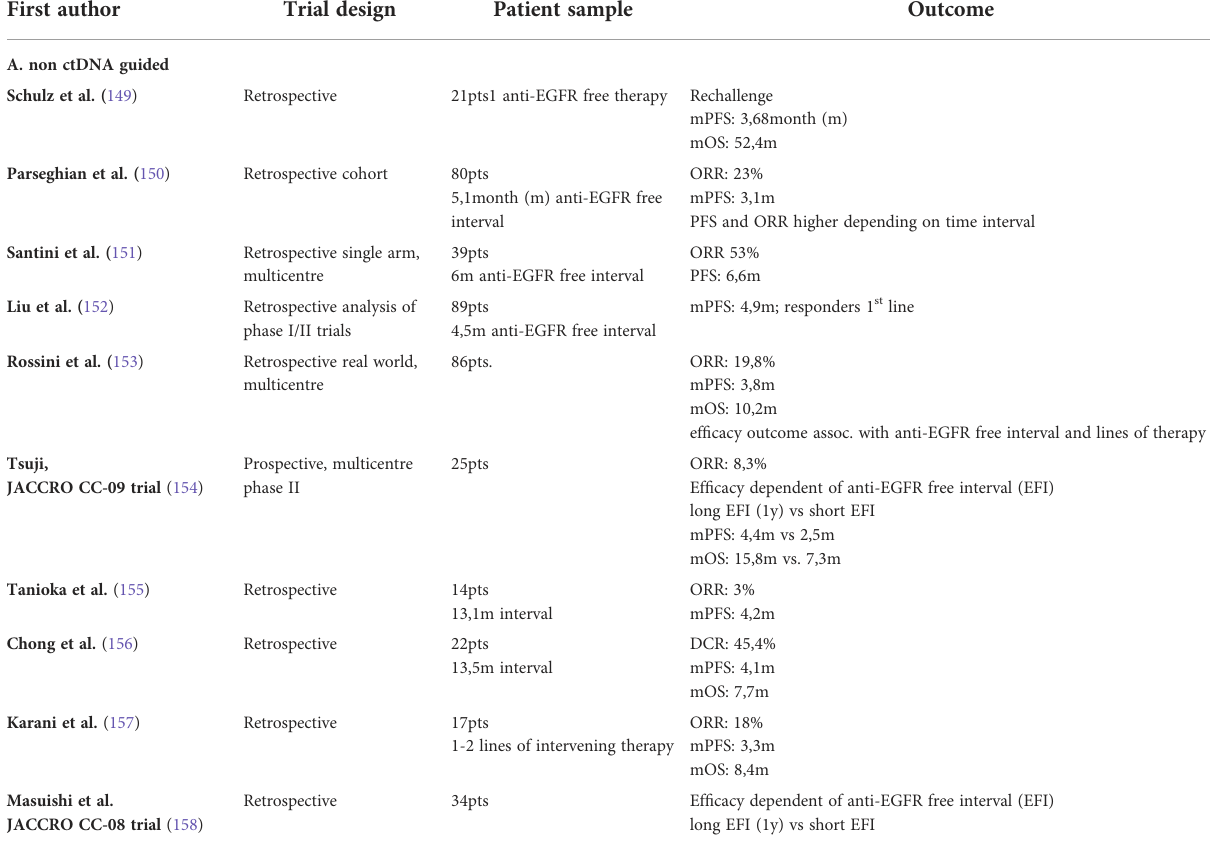
TABLE 1 Trials investigating re-challenge strategies either with or without ctDNA